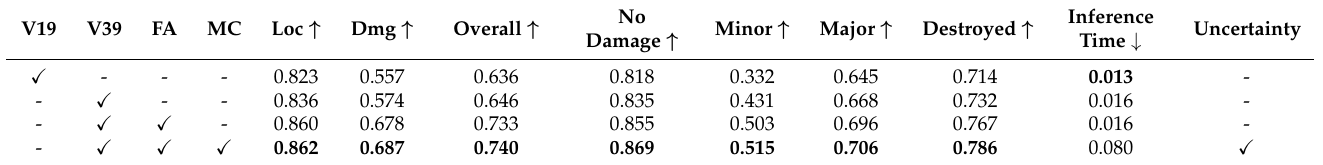
Table 5. The ablation study of the architecture in the proposed